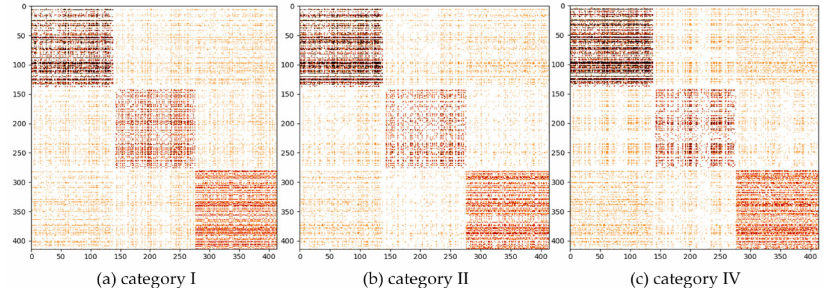
Figure 2. Weighted super adjacency matrices of various agricultural